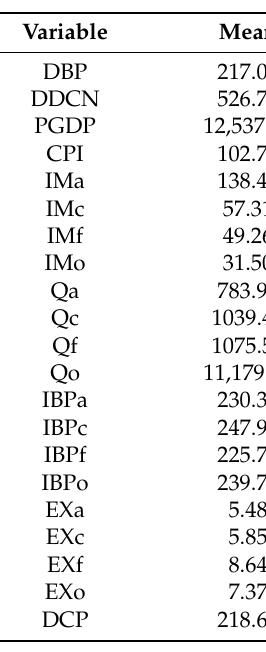
Table 3. Variables’ descriptive